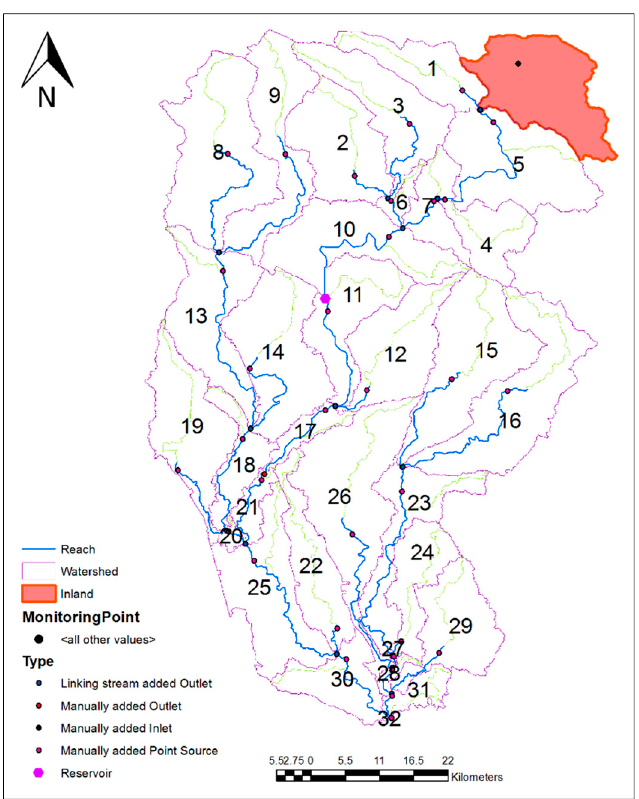
Figure 9. The delineated Dez River basin in the SWAT model.